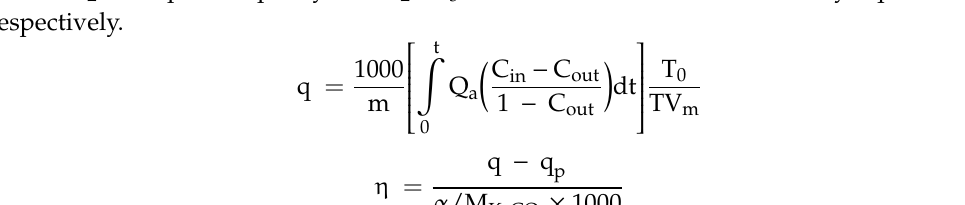
Figure 2. Fixed bed CO 2 adsorption system.